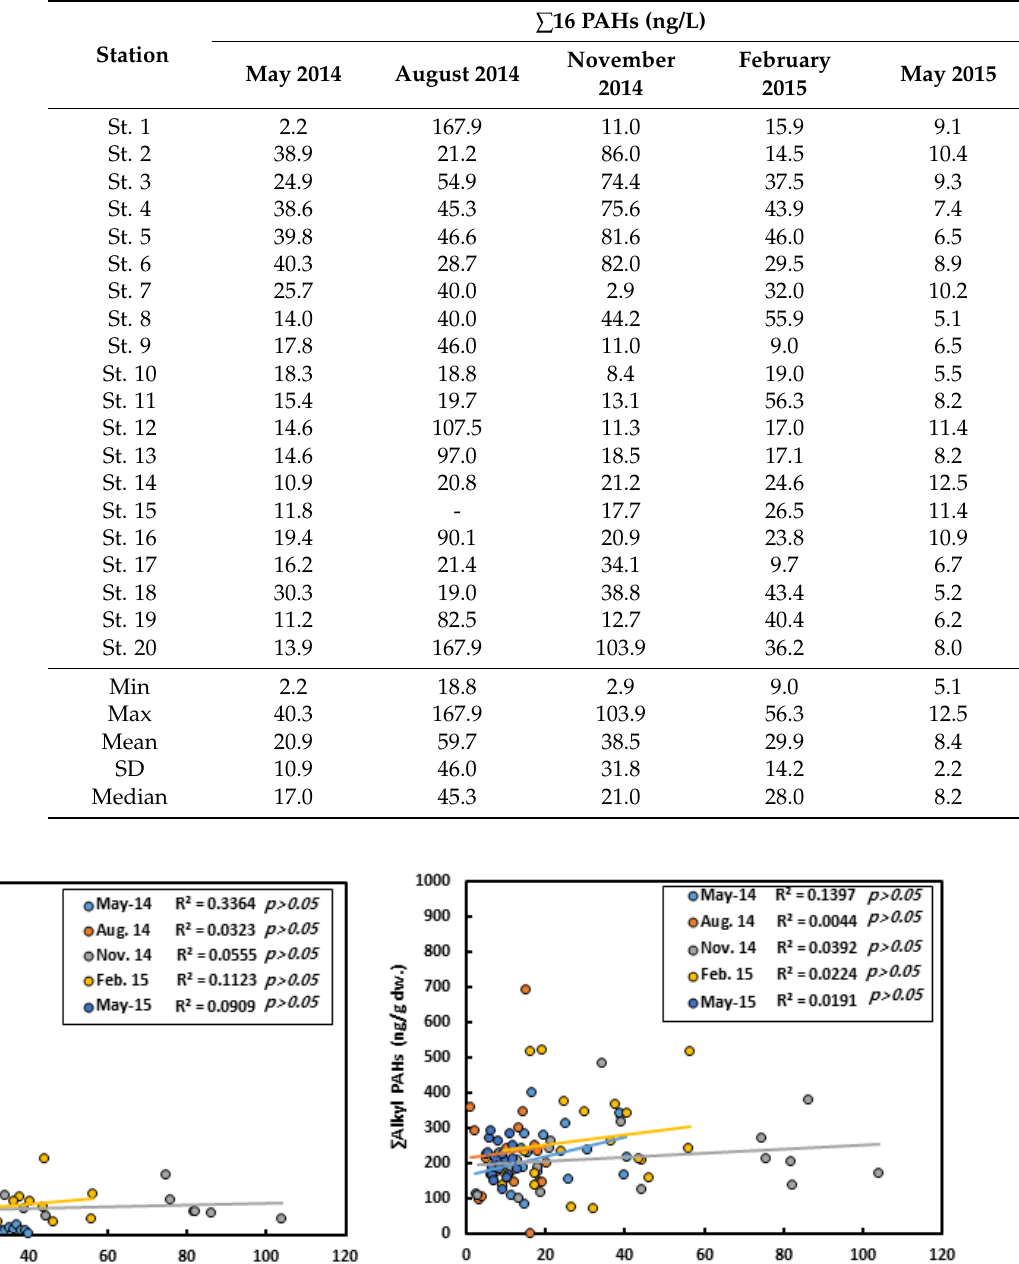
Table 6. Total concentrations of 16 PAHs and alkylated PAH concentrations in surface seawater in Gwangyang Bay and the Yeosu Channel.